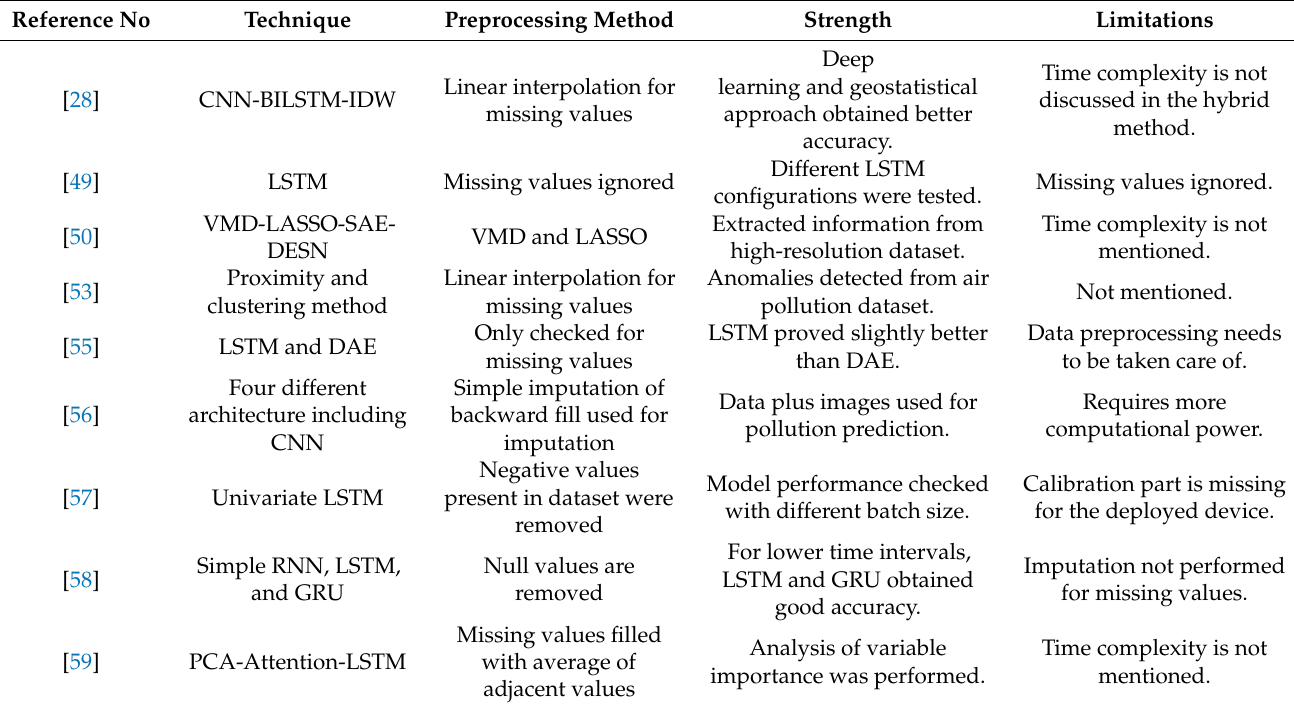
Table 1. Strength and limitations of forecasting techniques.